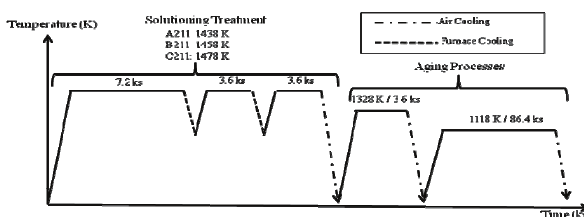
Figure 11. Simulated reheat treatment programs: A211, B211 and C211.